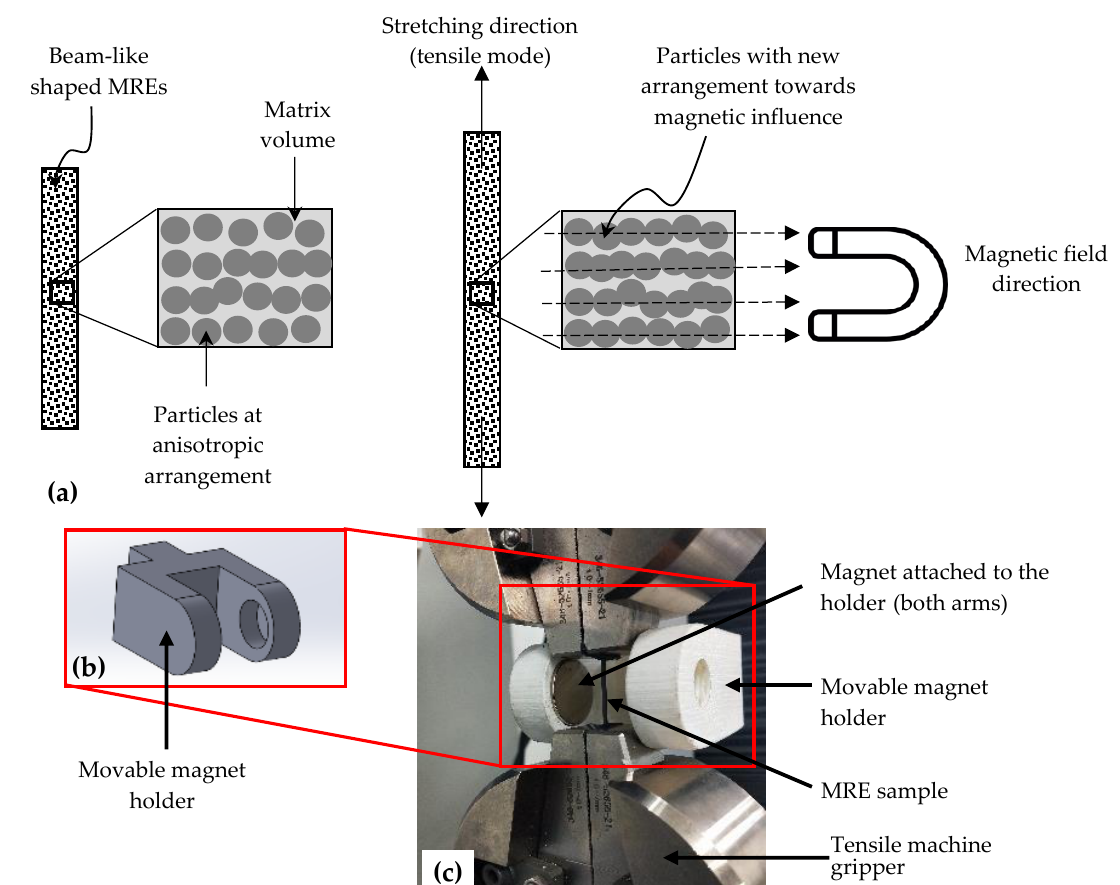
Figure 2. The test setup for quasi-static uniaxial tensile test is depicted: ( a ) schematic diagram ex- plaining the direction of stretching (tension mode), CIP arrangement, and magnetic field; ( b ) movable magnet holder; ( c ) the magnetic setup with permanent magnet at 30 mm inter-magnet distance that produces 50 mT magnetic field.